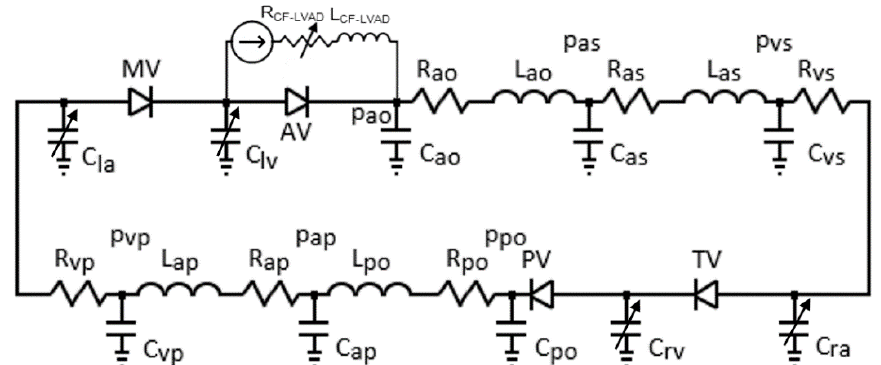
Figure 1. Electrical analogue of the cardiovascular system model. R, resistance; L, inertance; C, compliance; p, pressure; MV, mitral valve; AV, aortic valve; TV, tricuspid valve; PV, pulmonary valve; la, left atrium; lv, left ventricle; ra, right atrium; rv, right ventricle; ao, aorta; as, systemic arterioles; vs, systemic veins; po, pulmonary artery; ap, pulmonary arterioles; vp, pulmonary veins.